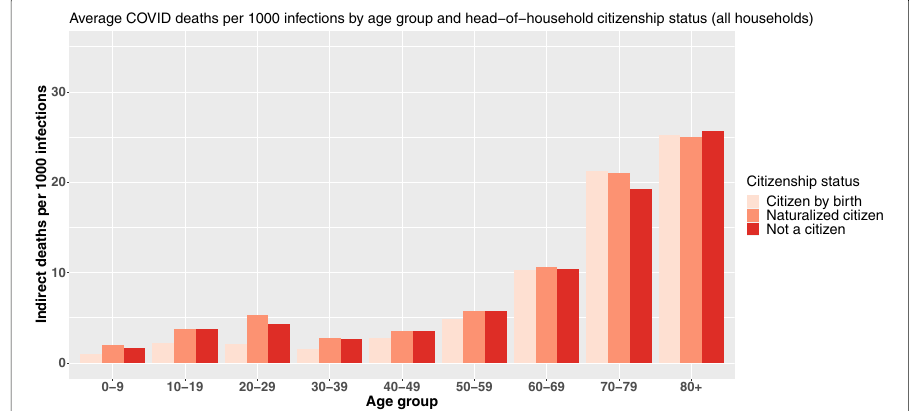
Fig. 5 Average COVID-19 indirect deaths per 1000 primary infections by age group and head-of-household citizenship status